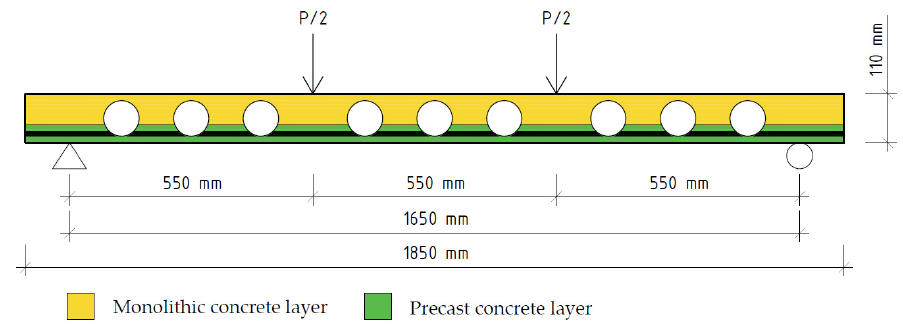
Figure 5. General view of the numerical model: ( a ) whole 3D slab model; ( b ) precast concrete layer; ( c ) meshed 3D model.